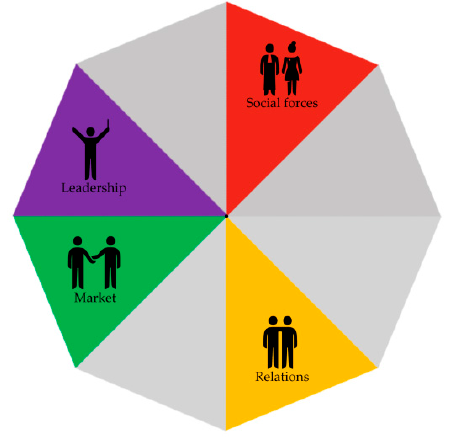
Figure 3. Building mutual trust .